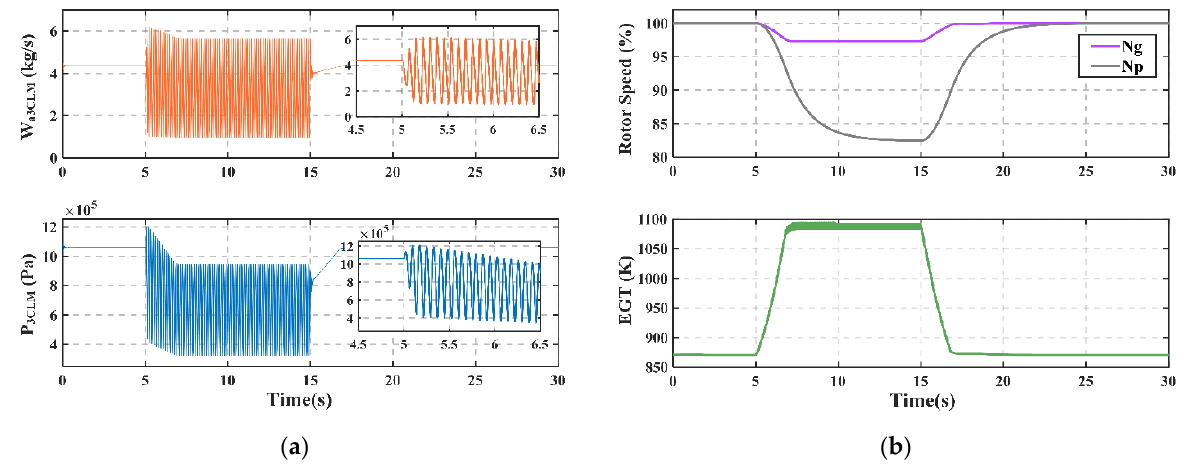
Figure 10. Simulation of surge dynamic process at design point: ( a ) The mass flow and pressure at compressor outlet; ( b ) Engine’s rotor speed and exhaust temperature.